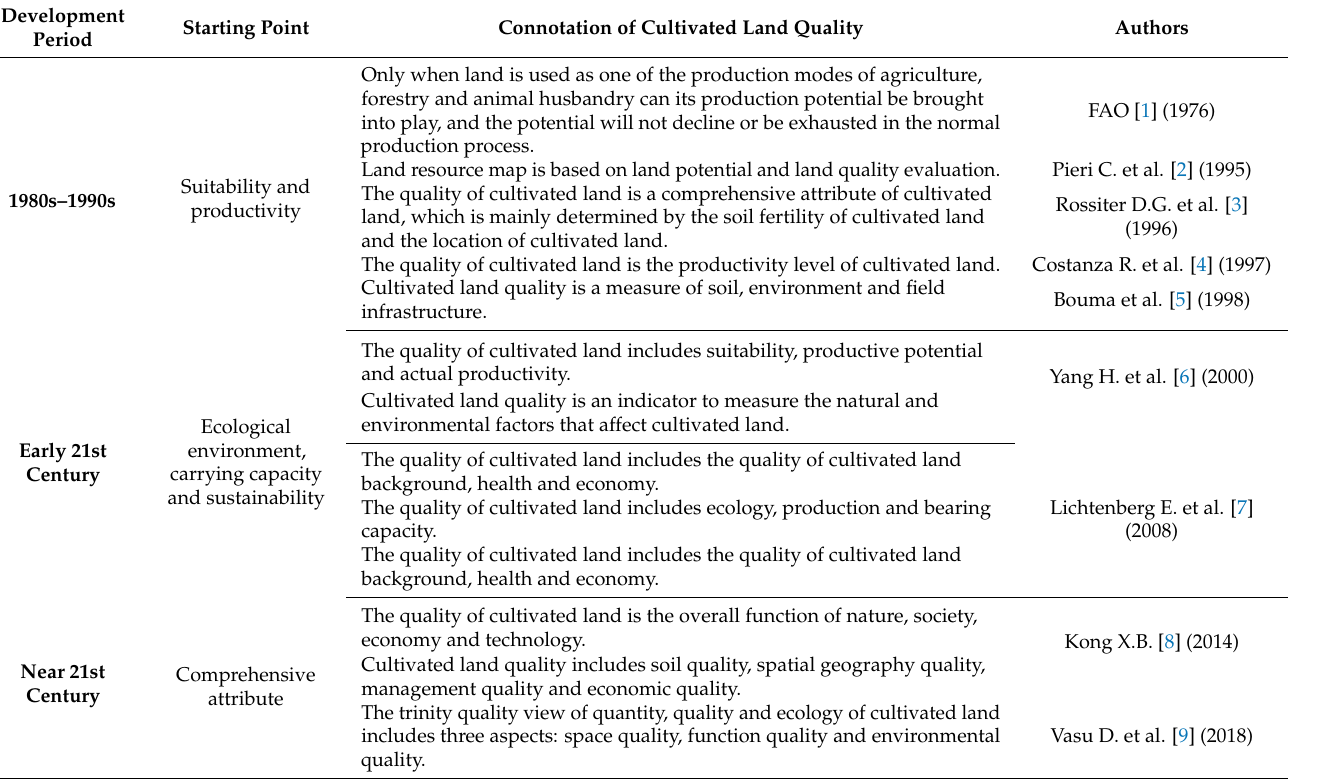
Table 1. Conceptual understandings of cultivated land